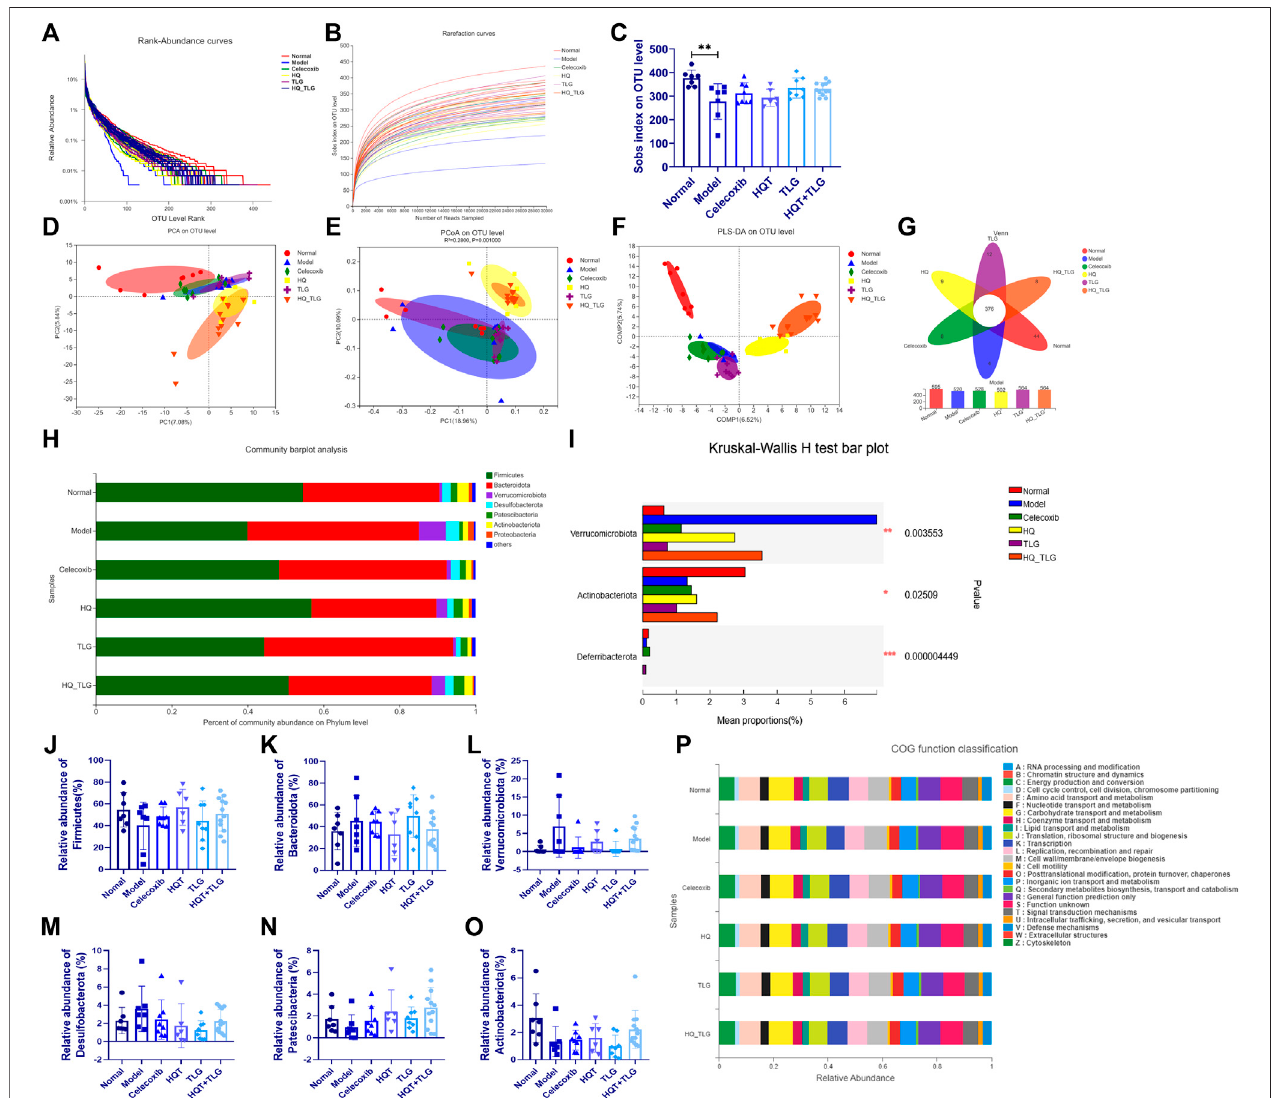
FIGURE 7 | Intestinal fl ora analysis and gene function classi fi cation. (A – C) Annotation and assessment of fl ora species. (D – O) Difference analysis of fl ora species. (P) Gene function classi fi cation.